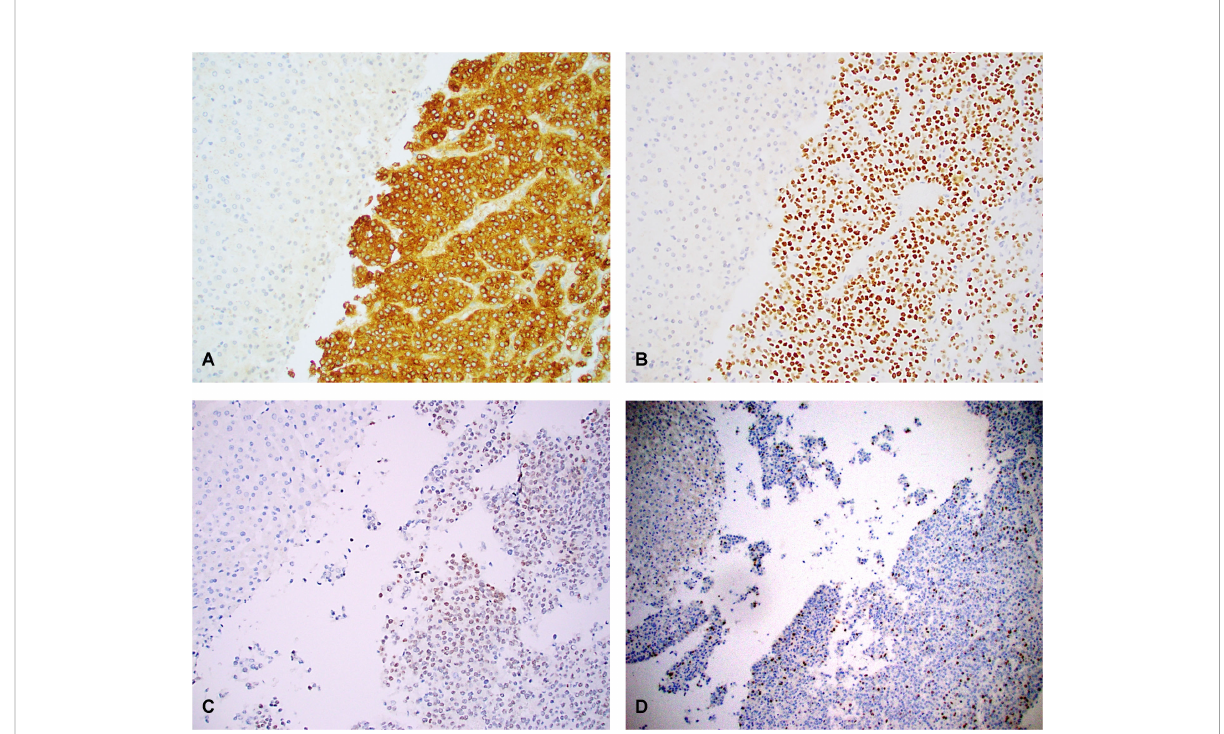
FIGURE 6 Overexpression of glypican 3 (A) , SALL4 (B) , HMGA2 (C) and FOXM1 (D) in case 3 with both uninvolved normal liver (left upper) and adjacent HCN-NOS tumor (right side). Tumor cells were positive for glypican 3 (moderate to strong cytoplasmic staining), SALL4 (moderate to strong nuclear staining), HMGA2 (patchy, weak to strong nuclear staining) and FOXM1 (scattered strong nuclear staining), In contrast, the normal liver cells (left upper) showed no staining for glypican 3, SALL4, HMGA2 and FOXM1. The results were consistent with the gene expression data obtained by RNAseq. Original magni fi cation: 100 x for